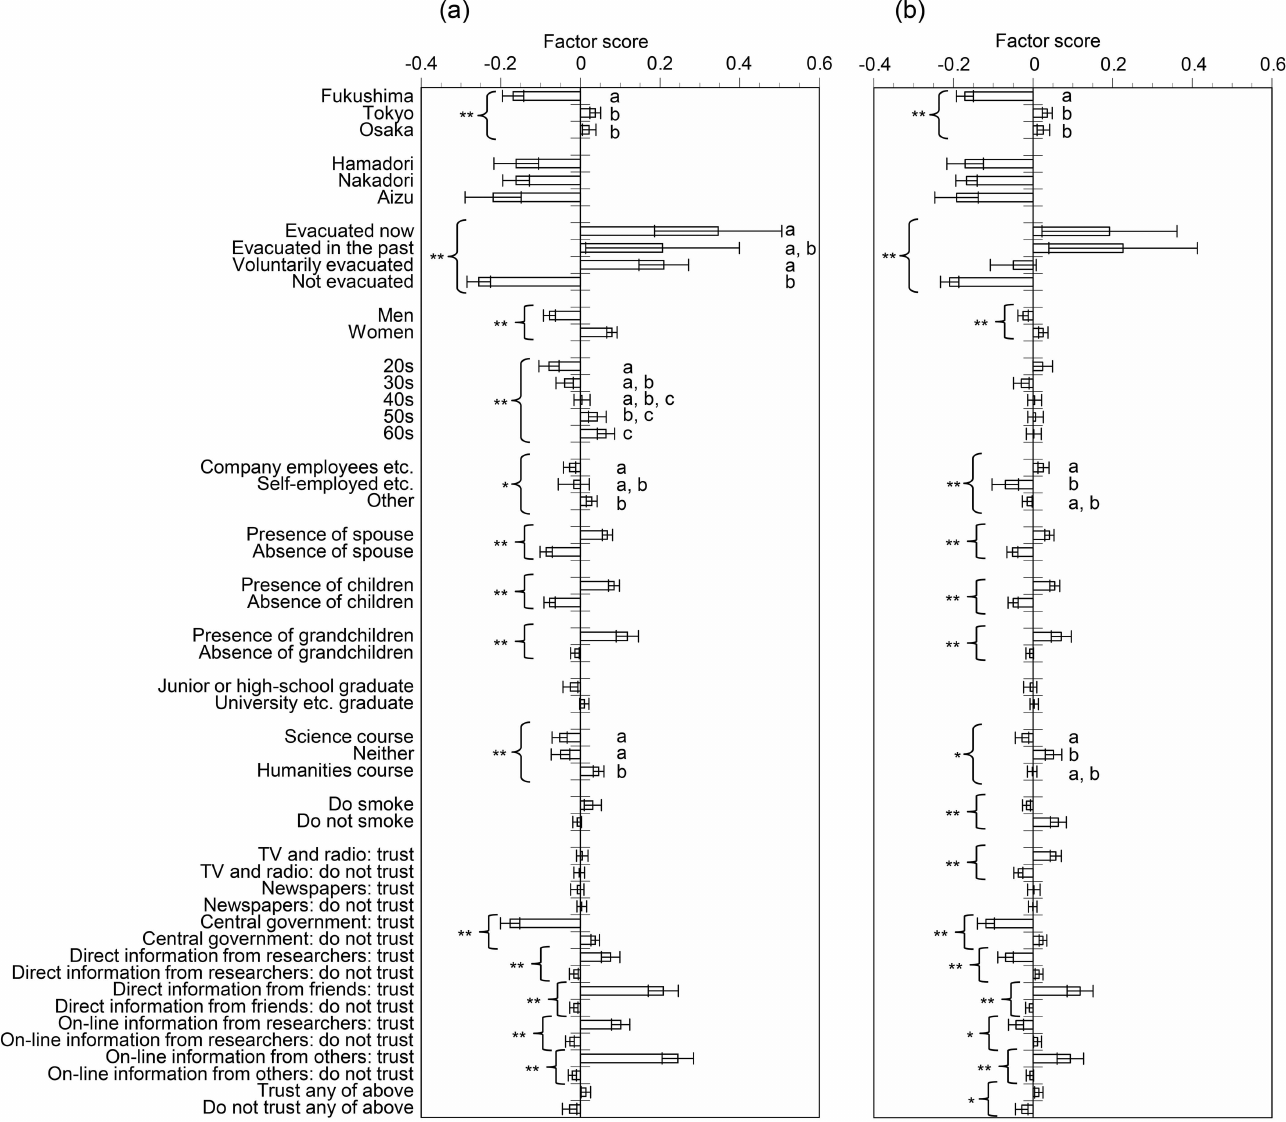
Fig 1. Factor scores for (a) dread risk and (b) unknown risk (reversed). Error bars represent standard errors. * P < 0.05, ** P < 0.01. Different letters represent significant differences among groups upon further analysis( P <